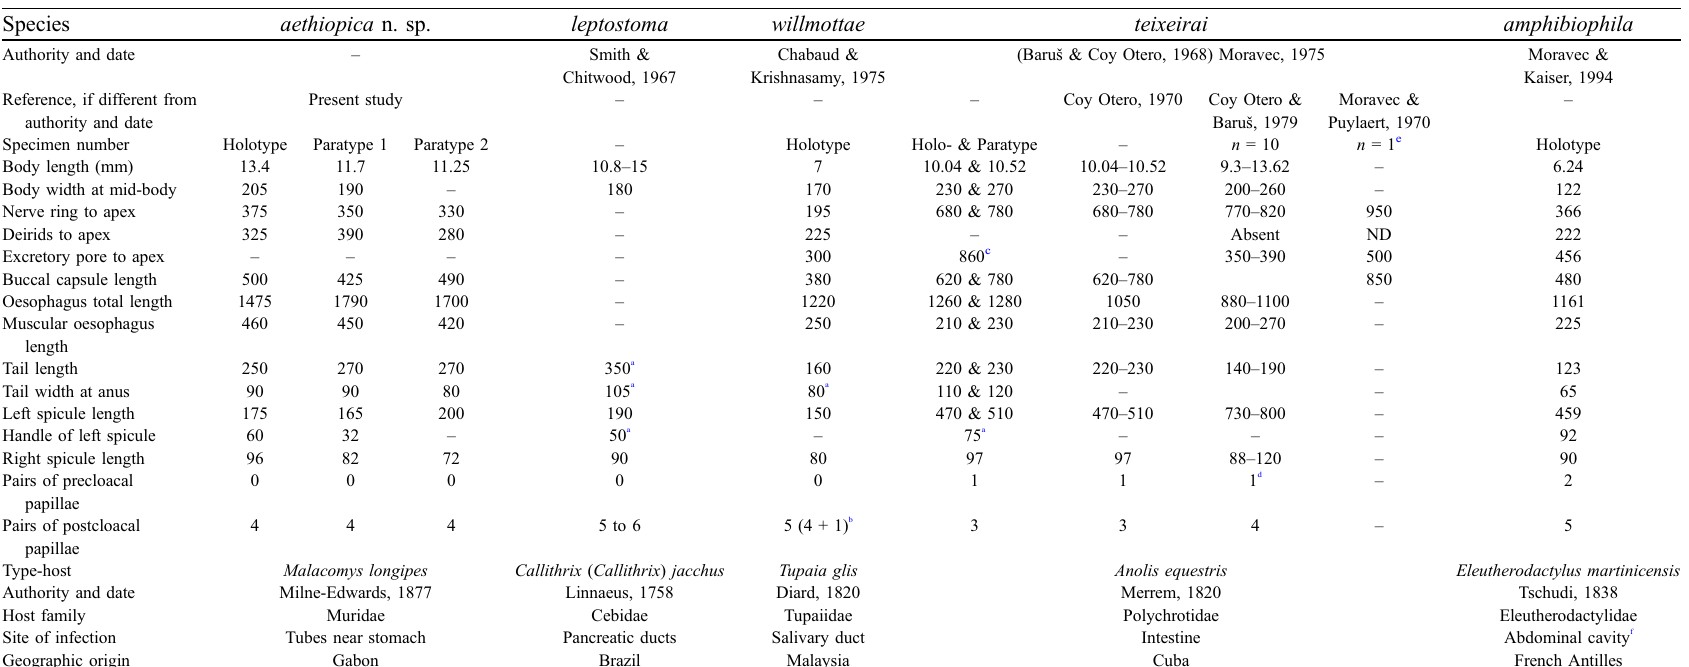
a measured on figures; b four pairs in anterior mid-part of tail and a subterminal pair; c according to Moravec & Puylaert (1970) this figure is incorrect and the excretory pore is situated more anteriorly; d sometimes absent; e measured on Figure 2G; f encapsulated near liver. Measurements in micrometres unless otherwise